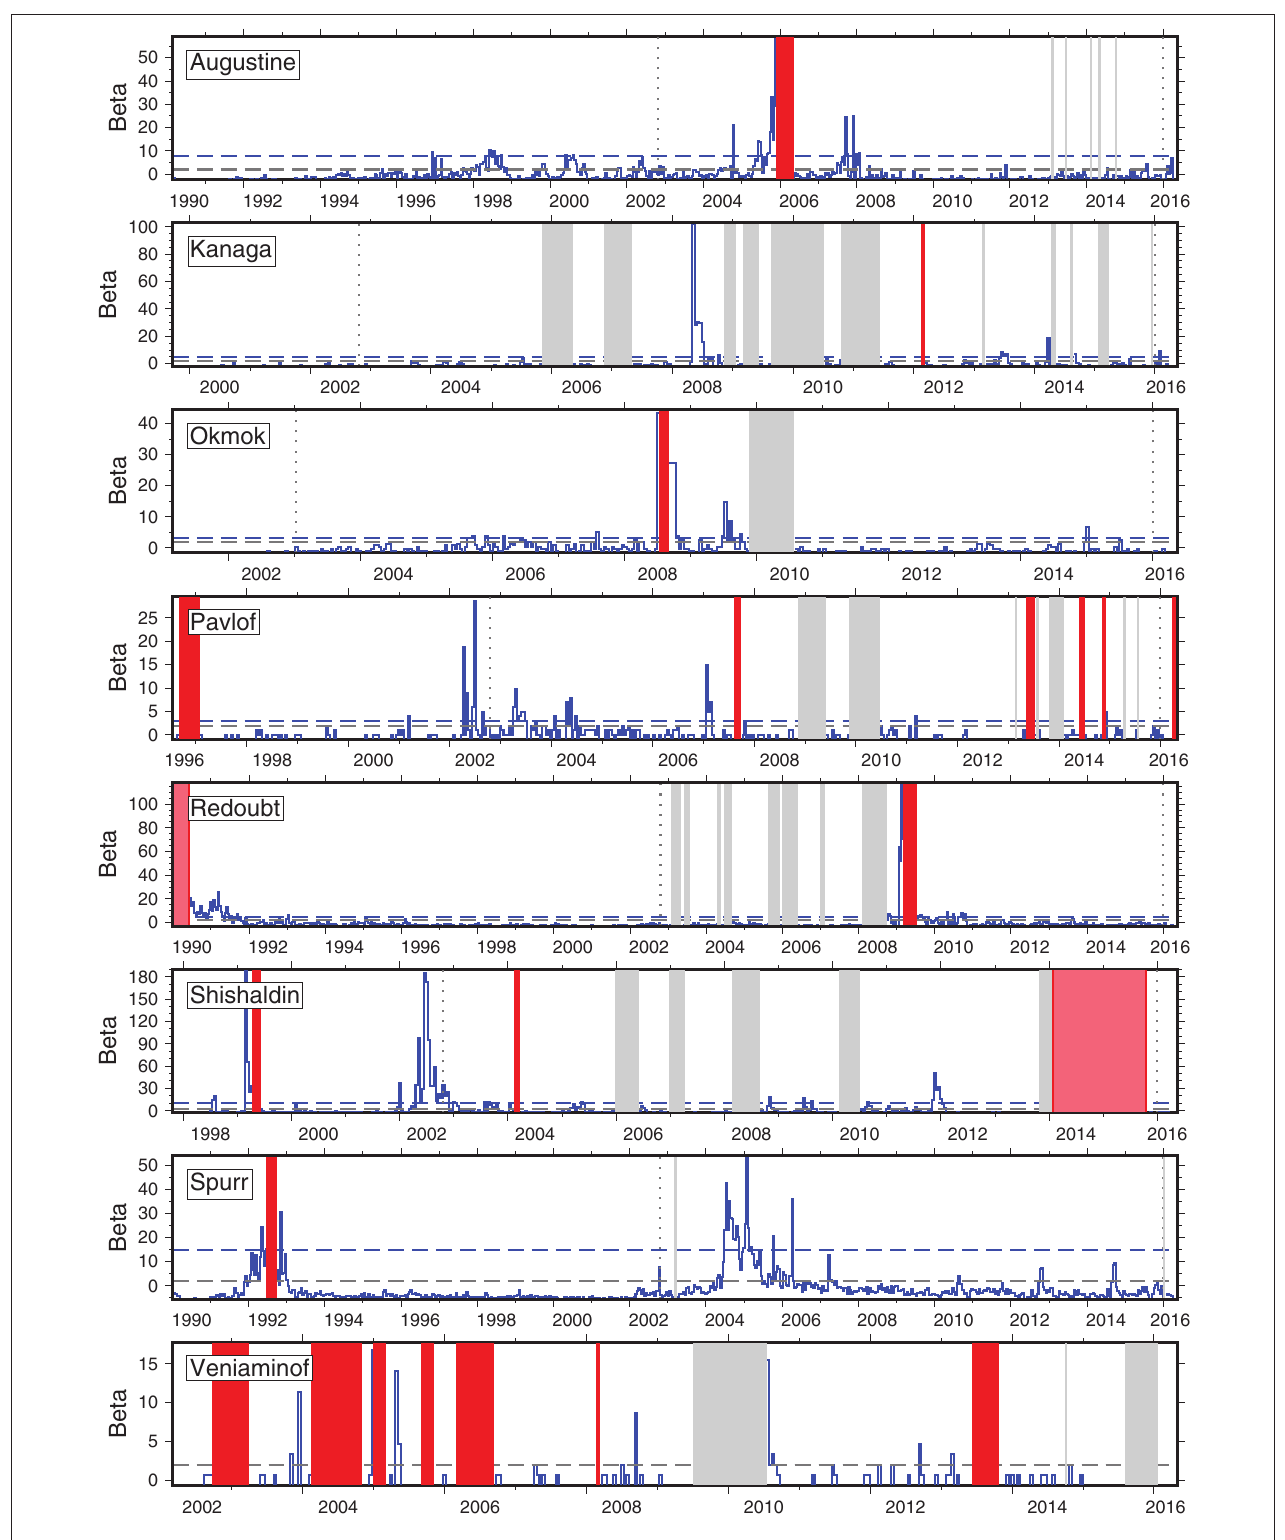
FIGURE 6 | Complete results for all nine volcanoes with eruptions analyzed for T a = 14 days and R = 20km, similar to Figure 3 . Note that the 1989 Redoubt and 2014 Veniaminof eruptions (light red) were not analyzed in this study due to lack of sufficient seismic monitoring. See Figure 2 for additional details.